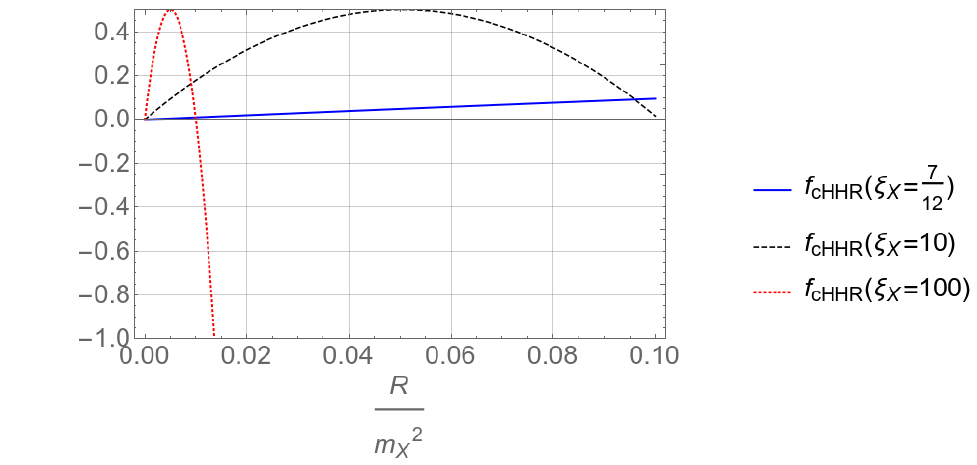
(cid:17) 2 (cid:0) (cid:1) R (cid:0) (cid:1) 2 (cid:16) R 2 (cid:24) X (cid:0) 1 (cid:0) 1 2 (cid:24) X (cid:0) 1 for some values of the 6 2 6 m 2 X m 2 X